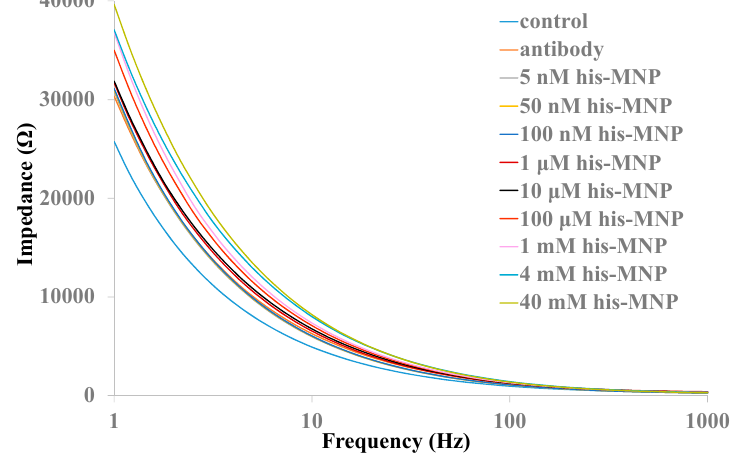
Figure 5. Impedance spectra of various histamine concentrations with MNPs in a nanoporous alumina membrane.